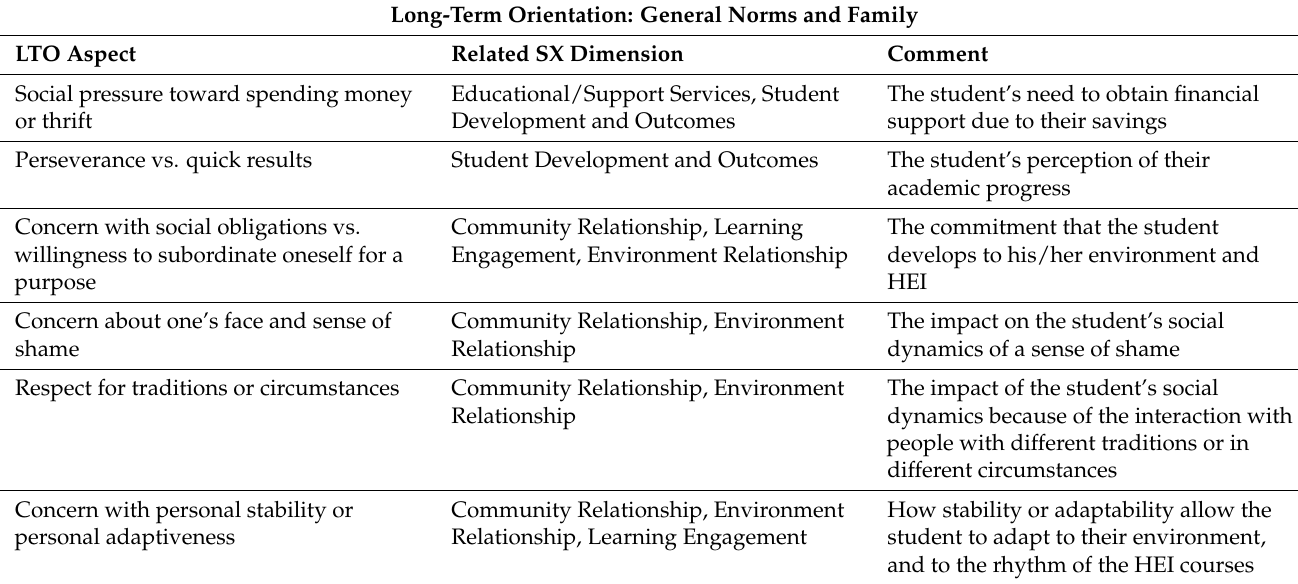
Table 5. General norms and family aspects of long-term orientation societies in